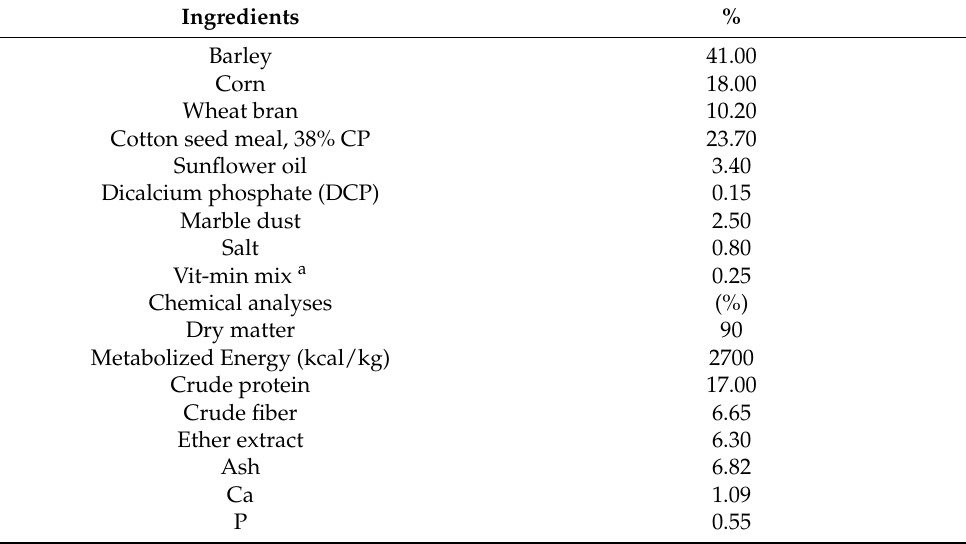
Table 1. Ingredients and chemical analysis of concentrate